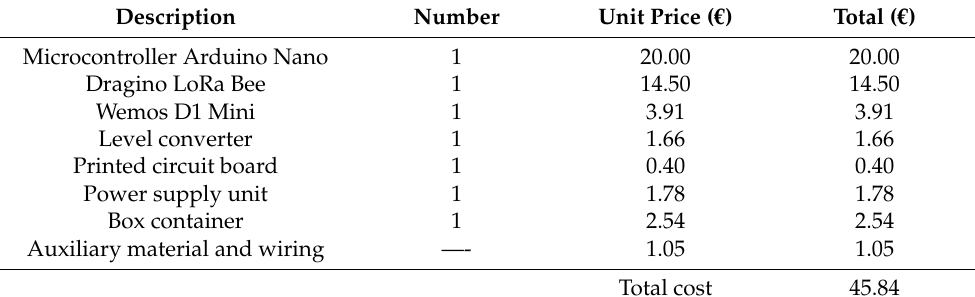
Table 5. Cost of the components for a GREMNL with a battery power supply.